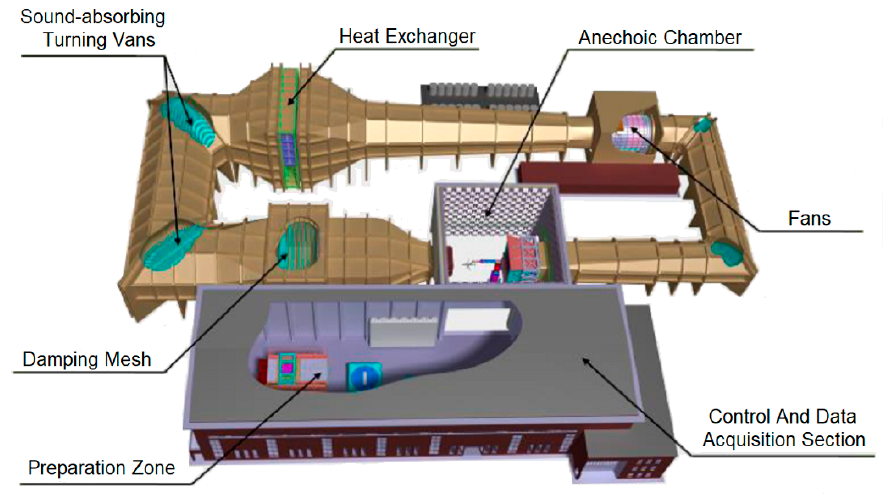
Figure 3. General scheme of FL-17 CARDC. For acoustic measurements, a linear microphone array was used that was located at the sideline from the landing gear model (Figure 4).